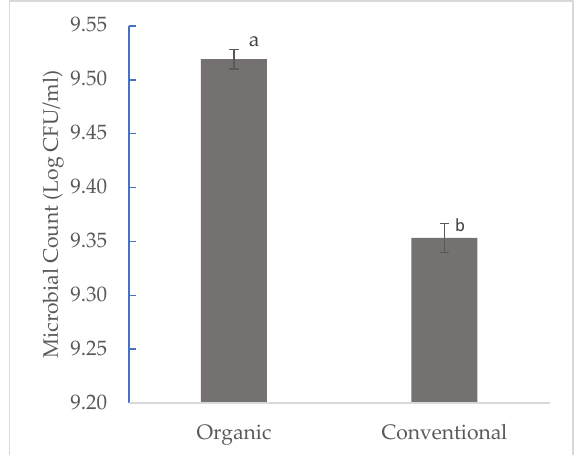
Figure 1. Effects of farming system on Enterobacteriaceae count of watermelon. a–b Mean with the same letters are not significantly different at p ˂ 0.05.